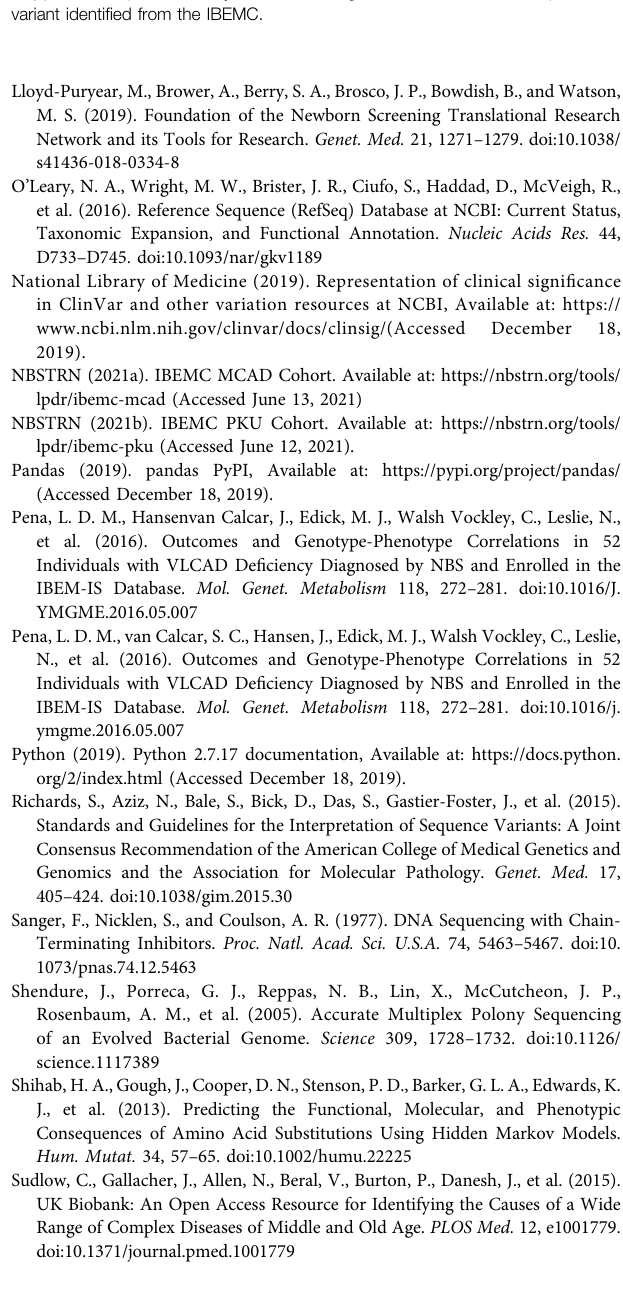
Supplementary Table S1 | Results of Sequence Variant Nomenclature according to the Human Genome Variation Society from Mutalyzer (Wildeman et al., 2008). Supplementary Table S2 | For each disorder, the number of subjects reporting a genotype are shown. Unique variants not found in ClinVar were assigned clinical signi fi cance and shown in the number of variants classi fi ed as Pathogenic, Likely Pathogenic, or remain as Variants of Uncertain Signi fi cance. Variants were assigned a clinical signi fi cance using data shown in Table 1 .